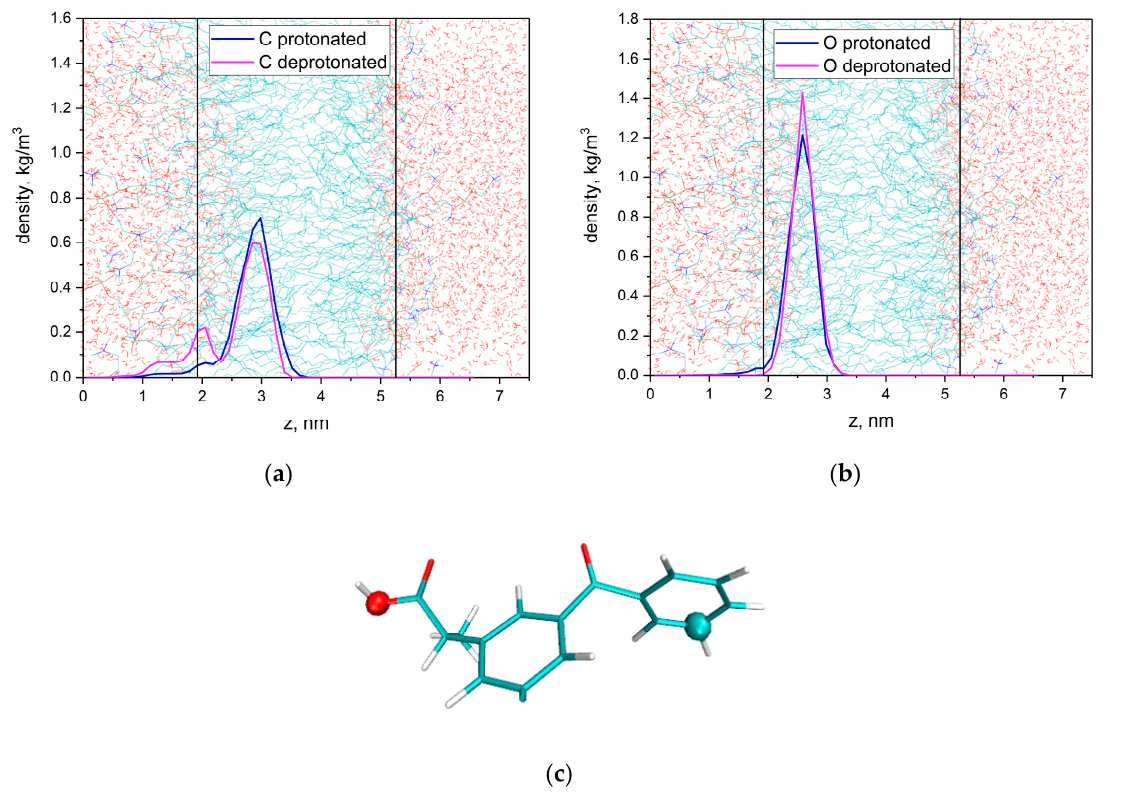
Figure 4. Density profiles of the selected C ( a ) and O ( b ) atoms of ketoprofen in protonated and deprotonated states and atom selections ( c ). Vertical lines correspond to the centers of density profiles of DMPC N atoms.